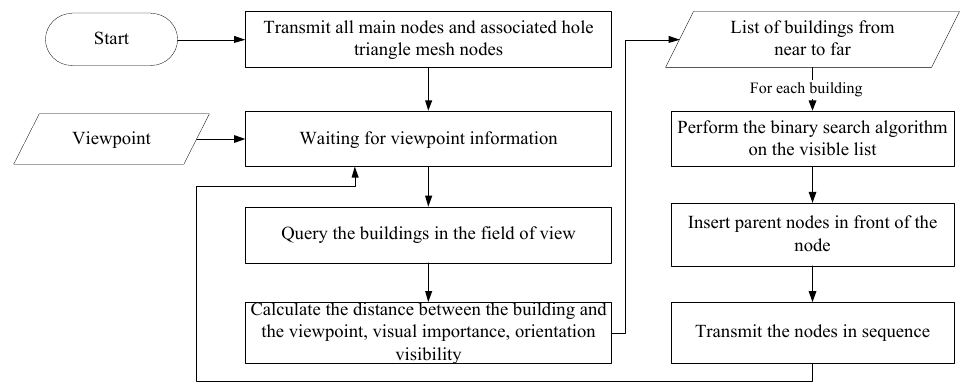
Figure 9. The flow chart of the server obtaining the transmission node.